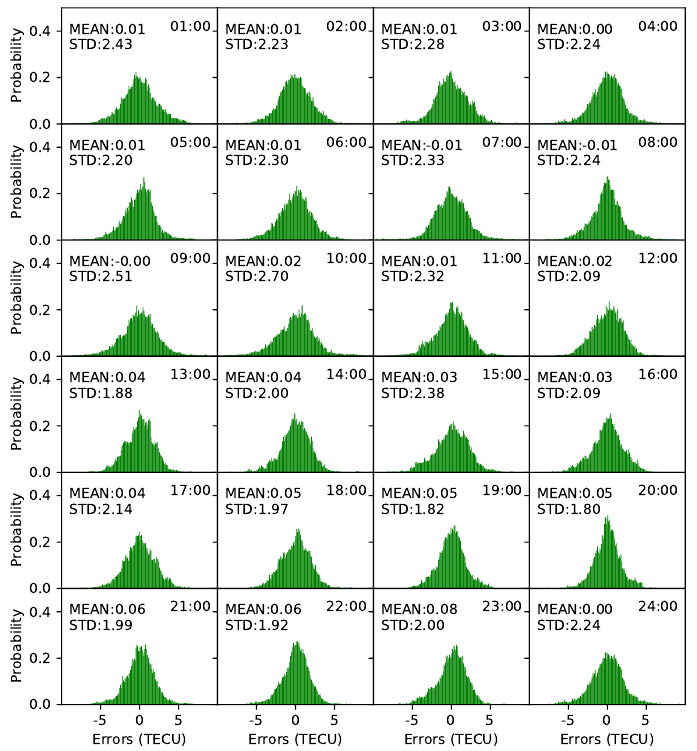
Figure 9. Frequency distribution histograms of model residuals on DOY 238,